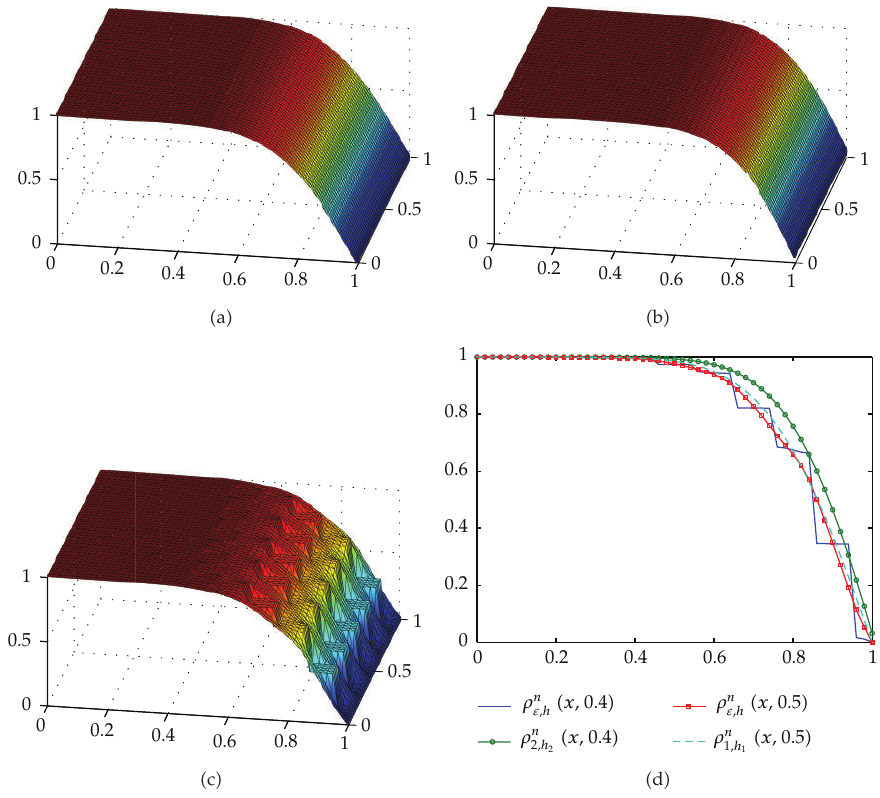
Figure 3: Numerical approximation at t n (cid:7) 3 × 10 − 2 of (cid:8) a (cid:9) and (cid:8) b (cid:9) the solutions of the two components of the macro-model (cid:8) 4.2 (cid:9) and (cid:8) c (cid:9) the solutions of the micro-model (cid:8) 2.8a (cid:9) and (cid:8) 2.8b (cid:9) . Figure (cid:8) d (cid:9) shows the side view of (cid:8) a, b, c (cid:9) at y (cid:7) 0 . 4 and y (cid:7) 0 . 5. Data from Example 3.2 with 1 /ε (cid:7) 5 and h (cid:7) h 1 (cid:7) h 2 (cid:7) 1 /